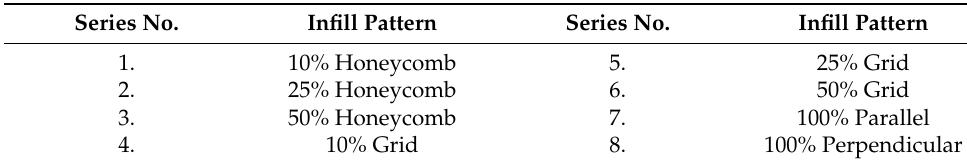
Table 1. Infill patterns of each printed series. Series No. Infill Pattern Series No. Infill Pattern 1. 10% Honeycomb 5. 25% Grid 2. 25% Honeycomb 6. 50% Grid 3. 50% Honeycomb 7. 100% Parallel 4. 10% Grid 8. 100%